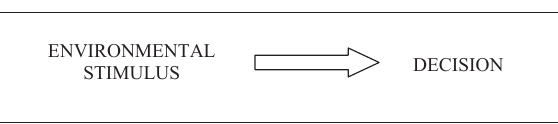
Figure 3. Cognitivist model: The fixed set of stimuli from the environment translated by switching connections to a fi xed set of possible decisions through some associative structure of me- diating